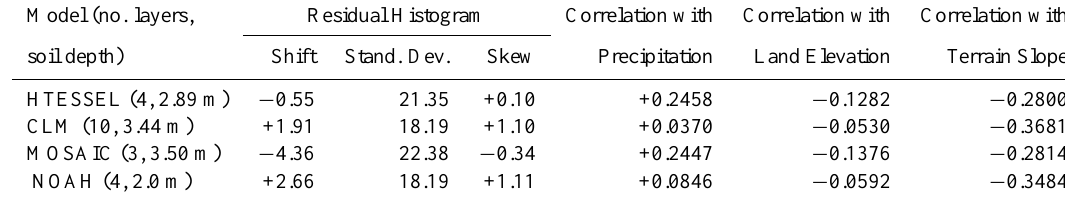
Table 1. Comparison of biases in the simulated WTD using four recharge estimates, for the continental validation. Model (no. layers, Residual Histogram Correlation with Correlation with Correlation with soil depth) Shift Stand. Dev. Skew Precipitation Land Elevation Terrain Slope HTESSEL (4, 2.89 m) − 0.55 21.35 +0.10 +0.2458 − 0.1282 − 0.2800 CLM (10, 3.44 m) +1.91 18.19 +1.10 +0.0370 − 0.0530 − 0.3681 MOSAIC (3, 3.50 m) − 4.36 22.38 − 0.34 +0.2447 − 0.1376 − 0.2814 NOAH (4, 2.0 m) +2.66 18.19 +1.11 +0.0846 − 0.0592 − 0.3484